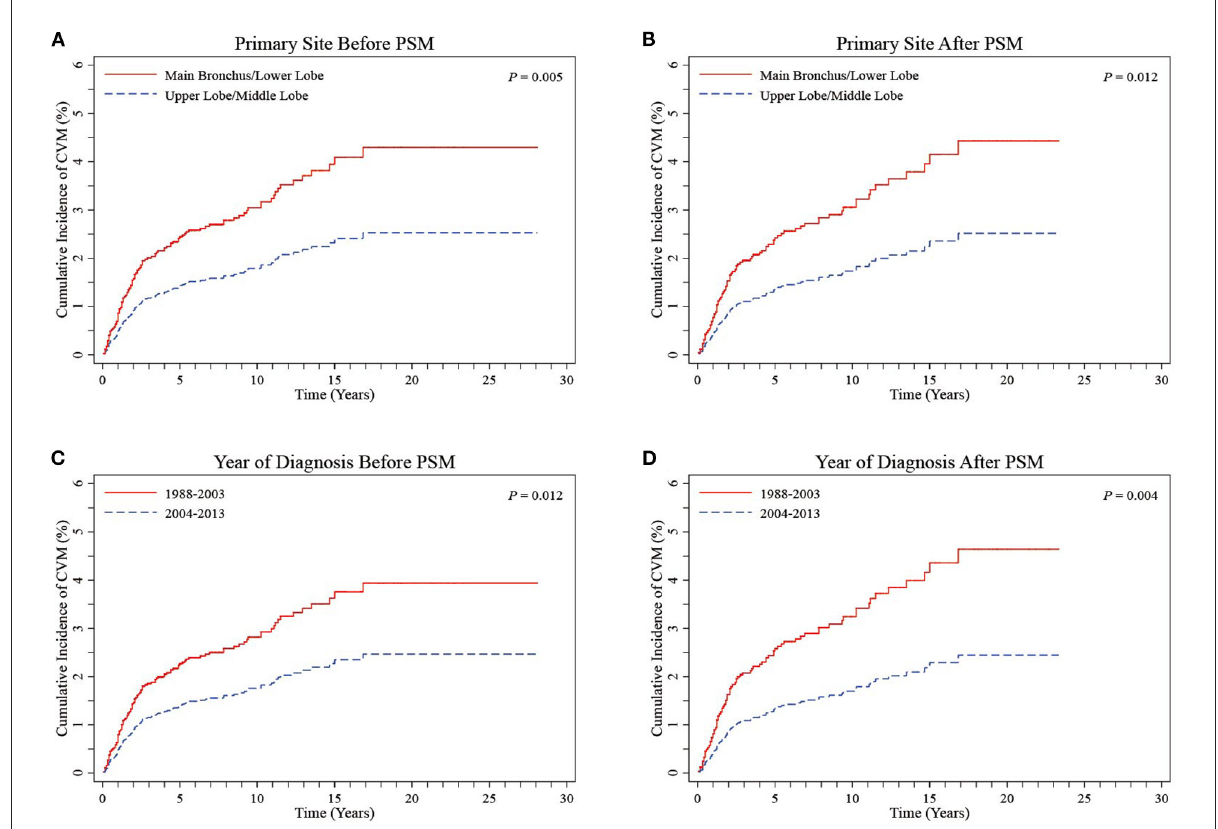
FIGURE4 CIF curves of CVM stratified into UL/ML and MB/LL groups by primary site before ( A) and after (B) PSM and stratified into 1988–2003 and 2004–2013 groups by year of diagnosis before (C) and after (D) PSM in LS-SCLC patients. CIF, cumulative incidence function; CVM, cardiovascular mortality; UL/ML, upper lobe/middle lobe; MB/LL, main bronchus/lower lobe; PSM, propensity score matching; LS-SCLC, limited-stage small cell lung